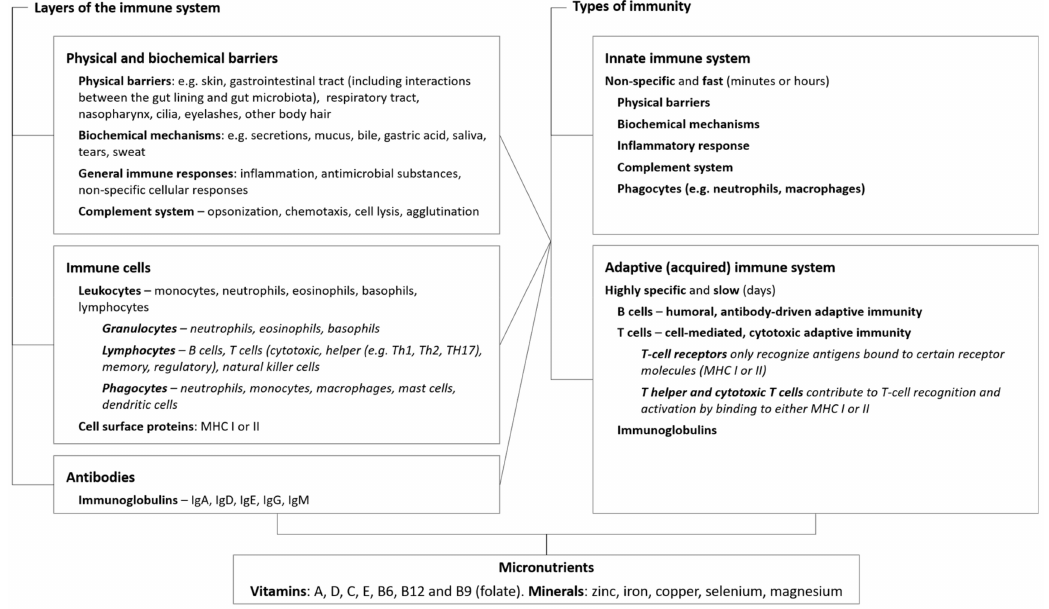
Figure 1. Basic components of the immune system, including key micronutrients that contribute to immune function. The schematic highlights the areas of immunity and the micronutrients that a ff ect these functions that are covered in this review. Abbreviations: Ig, immunoglobulins; MHC, major histocompatibility